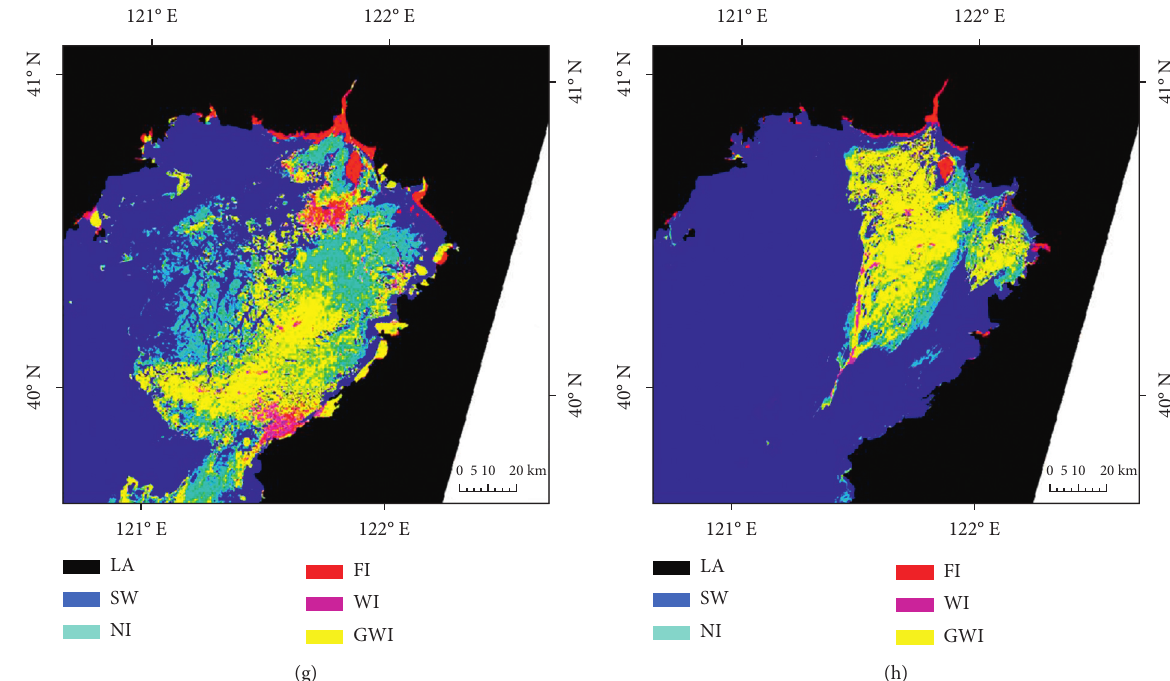
Figure 8: Distribution maps of sea ice types in Liaodong Bay during the freezing period in 2017/2018. (a–h) The distribution maps of sea ice types in Liaodong Bay on (a) 02/01/2018, (b) 12/01/2018, (c) 27/01/2018, (d) 01/02/2018, (e) 11/02/2018, (f) 16/02/2018, (g) 21/02/2018, and (h)